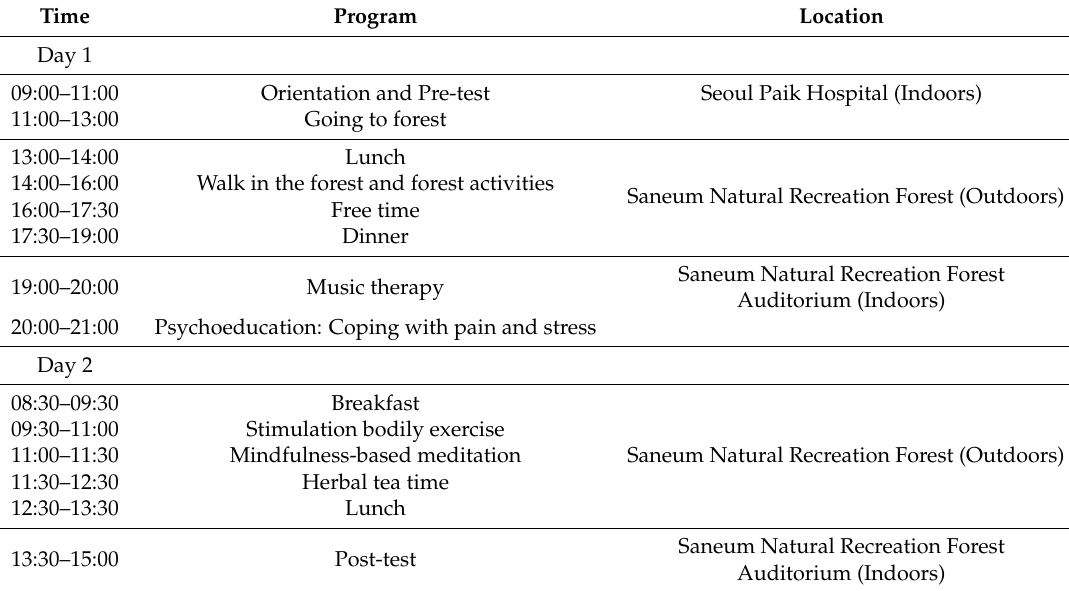
Table 2. Forest therapy camp program.